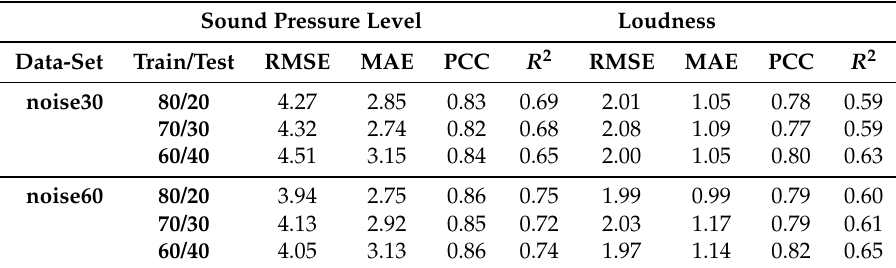
Table 5. Representation of RMSE, MAE, PCC and R 2 for different training and test percentages of L p and N